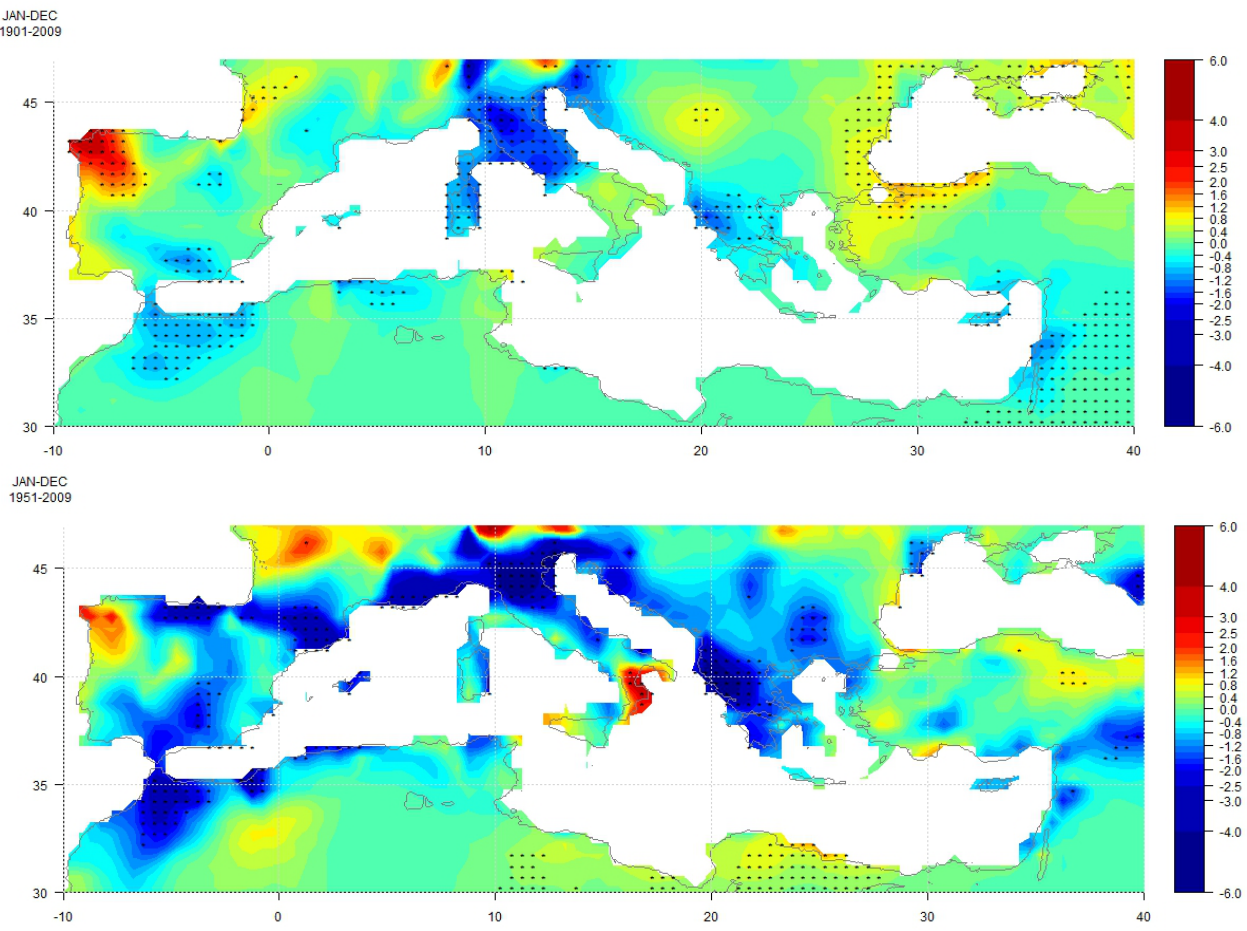
Fig. 3. Spatial distribution of annual precipitation trends concerning gridded datasets (CRU TS 3.1), for 1901–2009 (upper graph) and 1951–2002 (lower